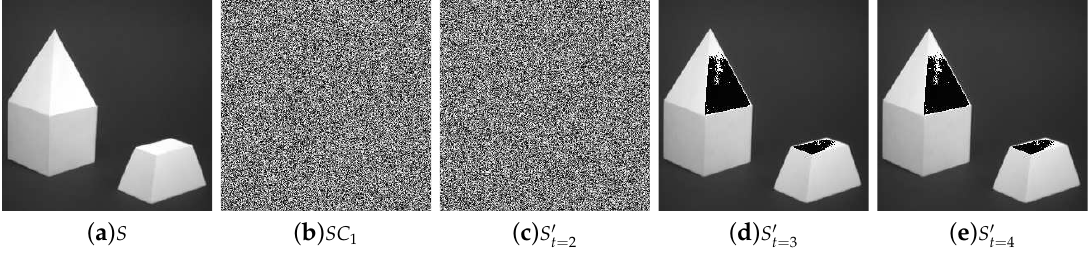
Figure 1. Shamir’s proposed polynomial-based secret image sharing for ( 3,4 )